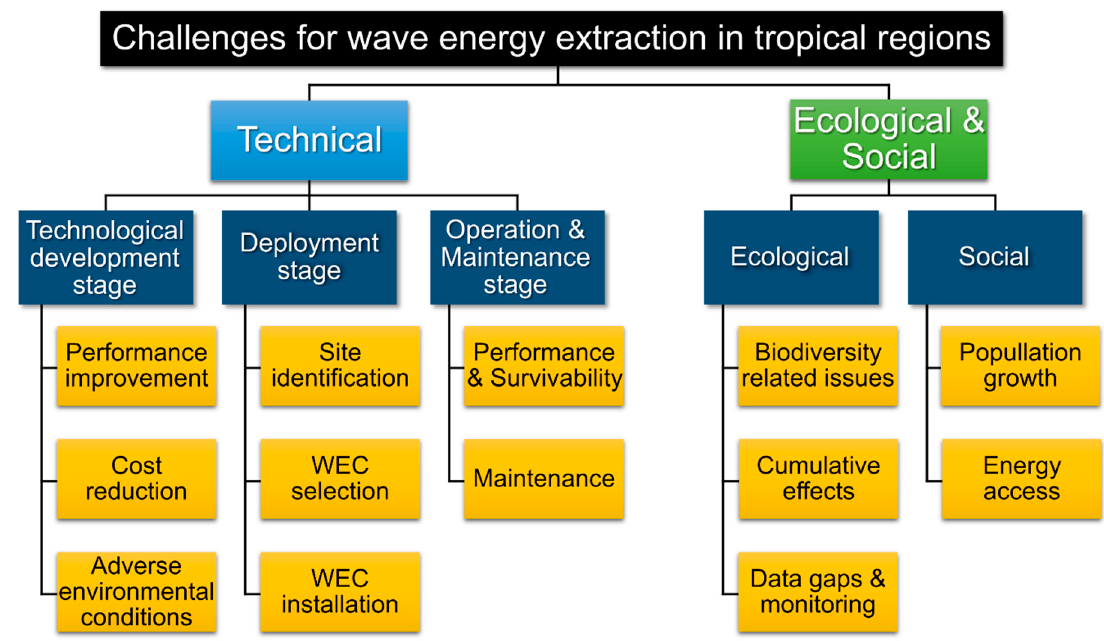
Figure 4. Challenges to be overcome in wave energy extraction projects in tropical regions.